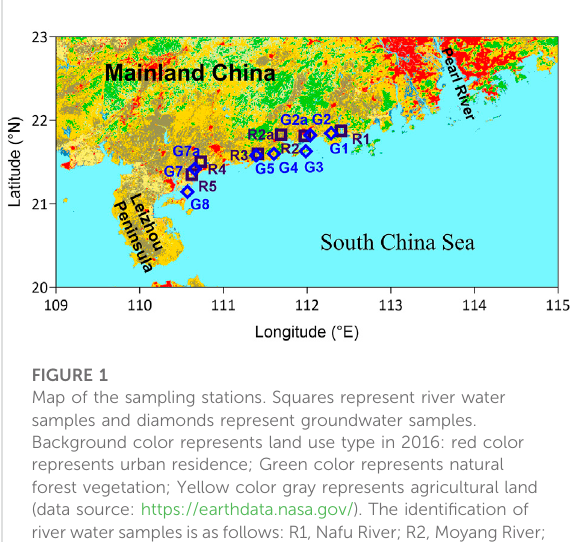
FIGURE 1 Map of the sampling stations. Squares represent river water samples and diamonds represent groundwater samples. Background color represents land use type in 2016: red color represents urban residence; Green color represents natural forest vegetation; Yellow color gray represents agricultural land (data source: https://earthdata.nasa.gov/). The identi fi cation of river water samples is as follows: R1, Nafu River; R2, Moyang River; R2a, Huangshi River; R3, Rudong River; R4 and R5, Jian